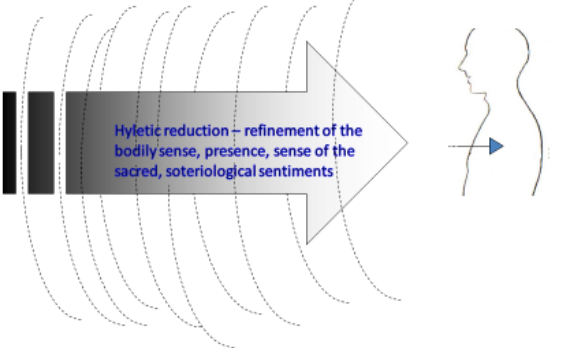
Figure 3 . A gradual “thinning out” of hyletic sense-data in the process of absorption in the PH. As a sense-datum in the somatic sense of the self, it serves as an organizing matrix for the